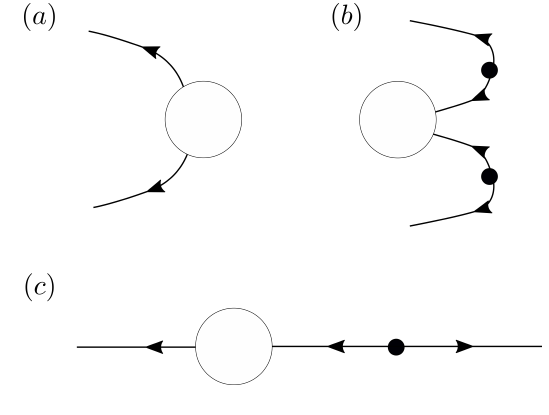
Figure 5: The diagrammatic representation of the terms in Eq.